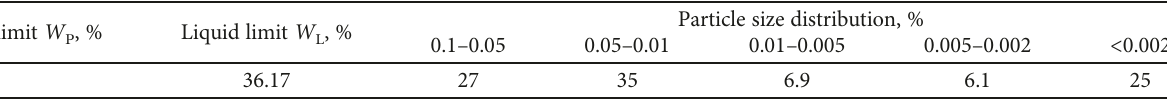
Figure 8: Manufactured axle mounted with wheels. (a) Conventional tooth. (b) Bionic tooth. Table 1: The soil mechanical composition (sizes in mm).